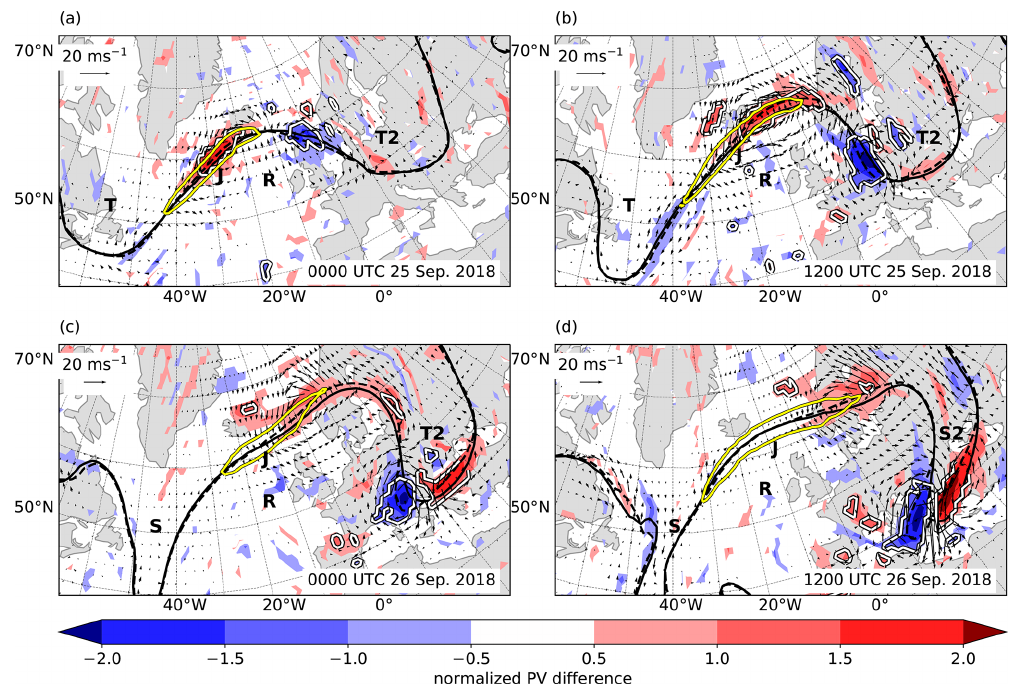
Figure 10. As Fig. 9 but with difference winds (arrows, only if larger than 1ms − 1 ; reference vectors are in top left of panels), without 9PVU contours and from 00:00UTC 25 September to 12:00UTC 26 September every 12h.